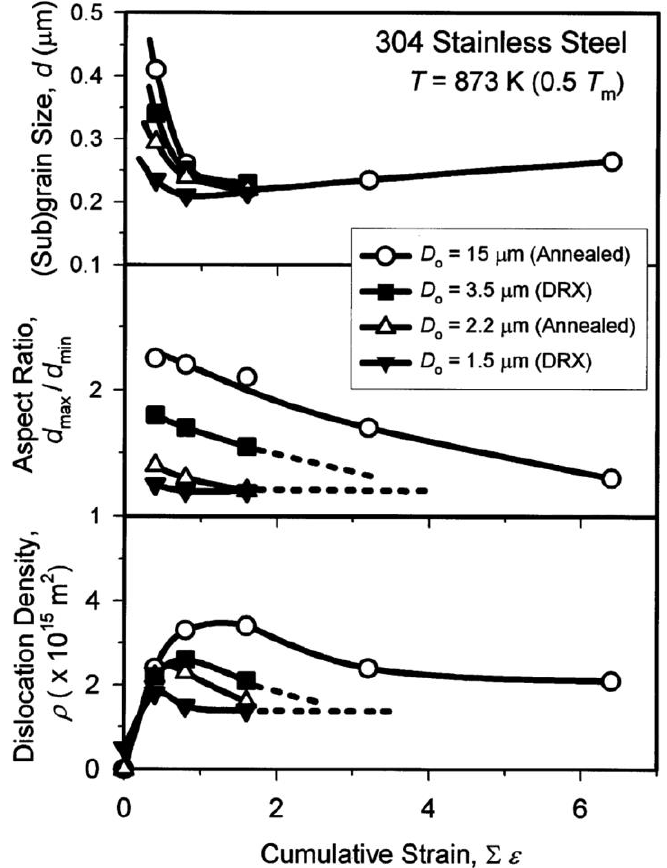
Figure 26. Effect of initial grain size on the (sub)grain size, the aspect ratio, and the dislocation density evolved in a 304-type stainless steel subjected to multiple forging at 873 K. Reproduced from [97] with permission from Elsevier, 2023.